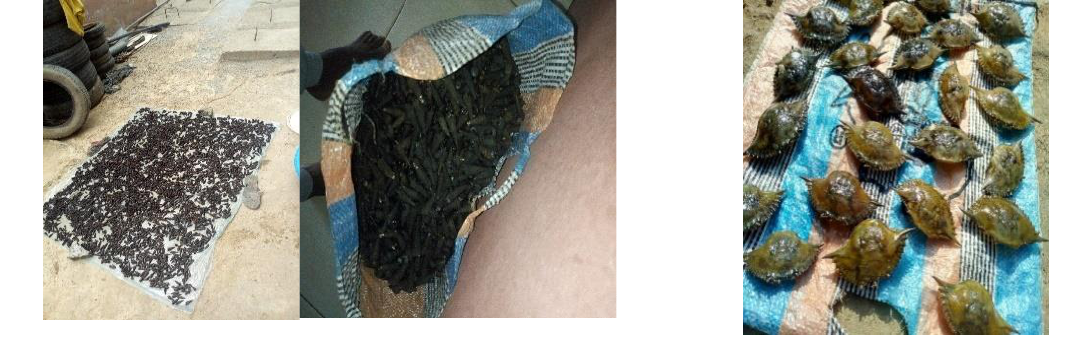
Figures 1: Samples of the periwinkle shells and crabs used in this